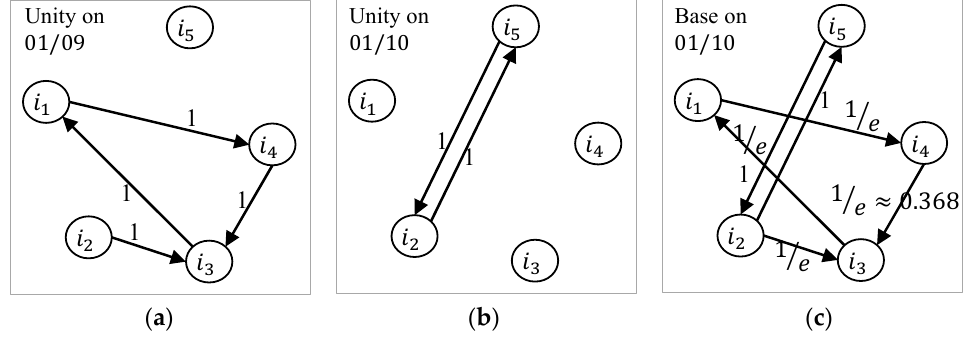
Figure 5. Construction of base graph on 10 January 2017. ( a ) A unity graph on 9 January. ( b ) A unity graph on 10 January. ( c ) A base graph on 10 January.